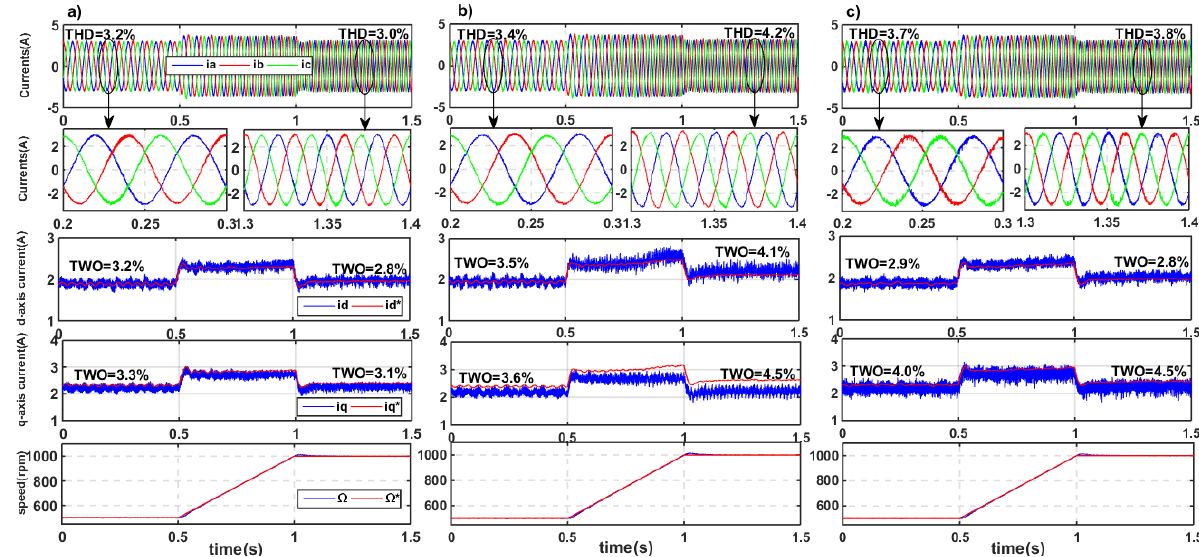
Figure 9. Experimental results under 2 N.m and speed variation: ( a ) MBPCC with nominal parameters, ( b ) MBPCC under the influence of parameter variations (0.5xLd, 0.5xLq), ( c ) proposed GW − MFPCC.